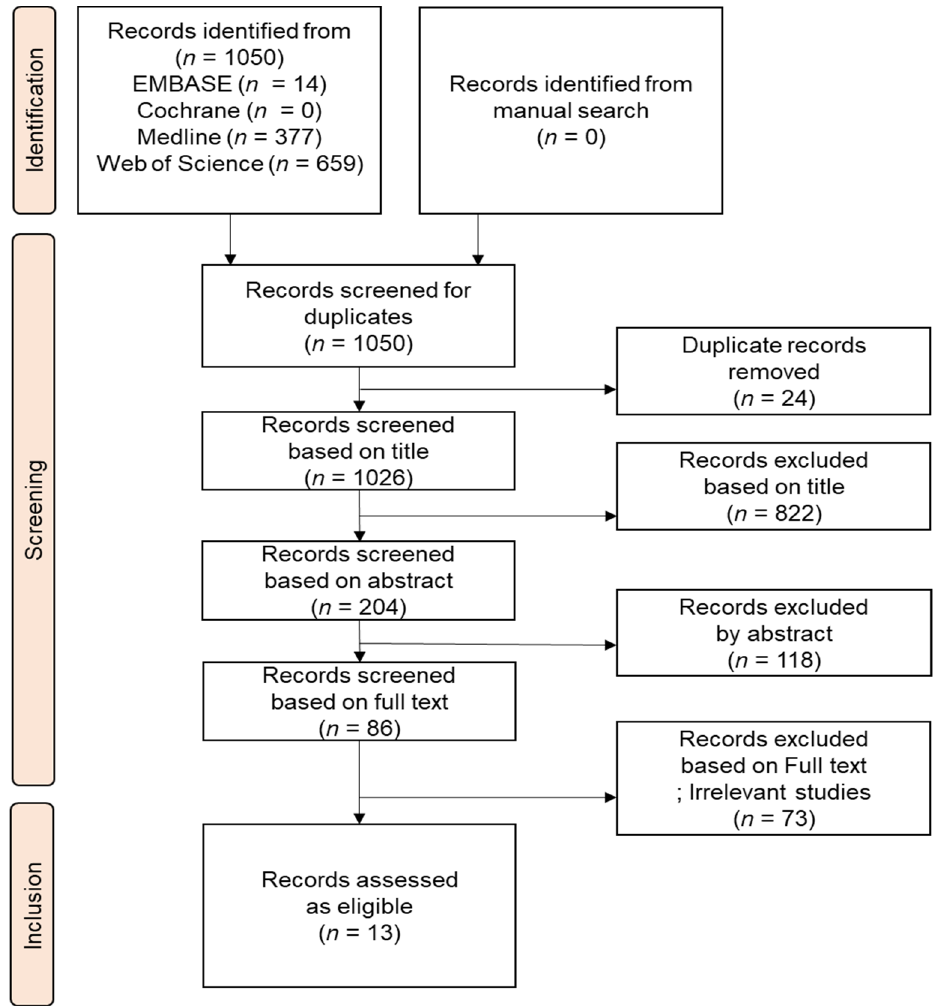
Figure 1. PRISMA flowchart of the search and selection procedure used to identify the studies reviewed here.